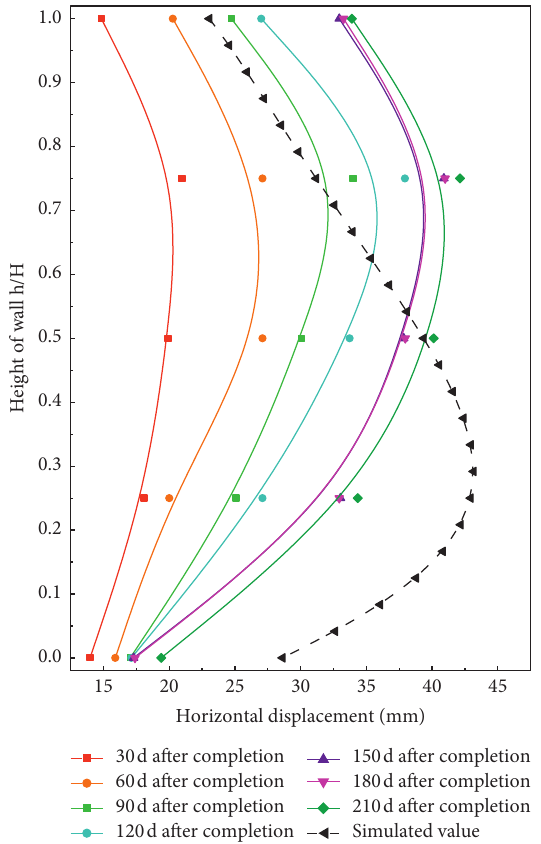
Figure 10: Measured displacement with consolidation